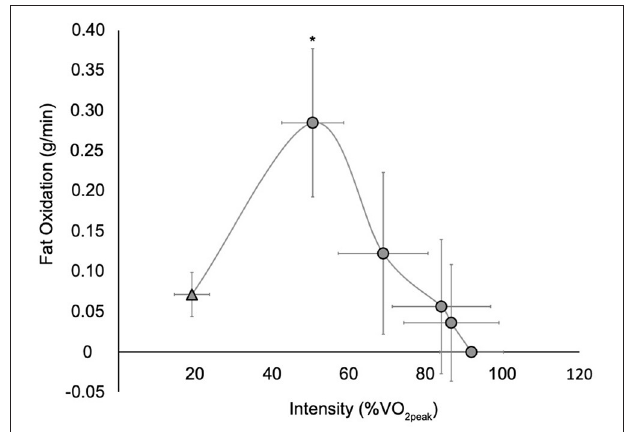
FIGURE 1 | Whole body fat oxidation at rest ( ) and during a graded exercise test ( ). Values are mean ± SD; n = 10. VO 2peak , peak oxygen consumption. All participants completed rest and stages 1 through 3, while four participants completed stage 4 and two participants completed stage 5. *Significantly different than rest and stages 2–3 ( p < 0.001) (stages 4 and 5 were not included in the analysis as few participants completed these stages).